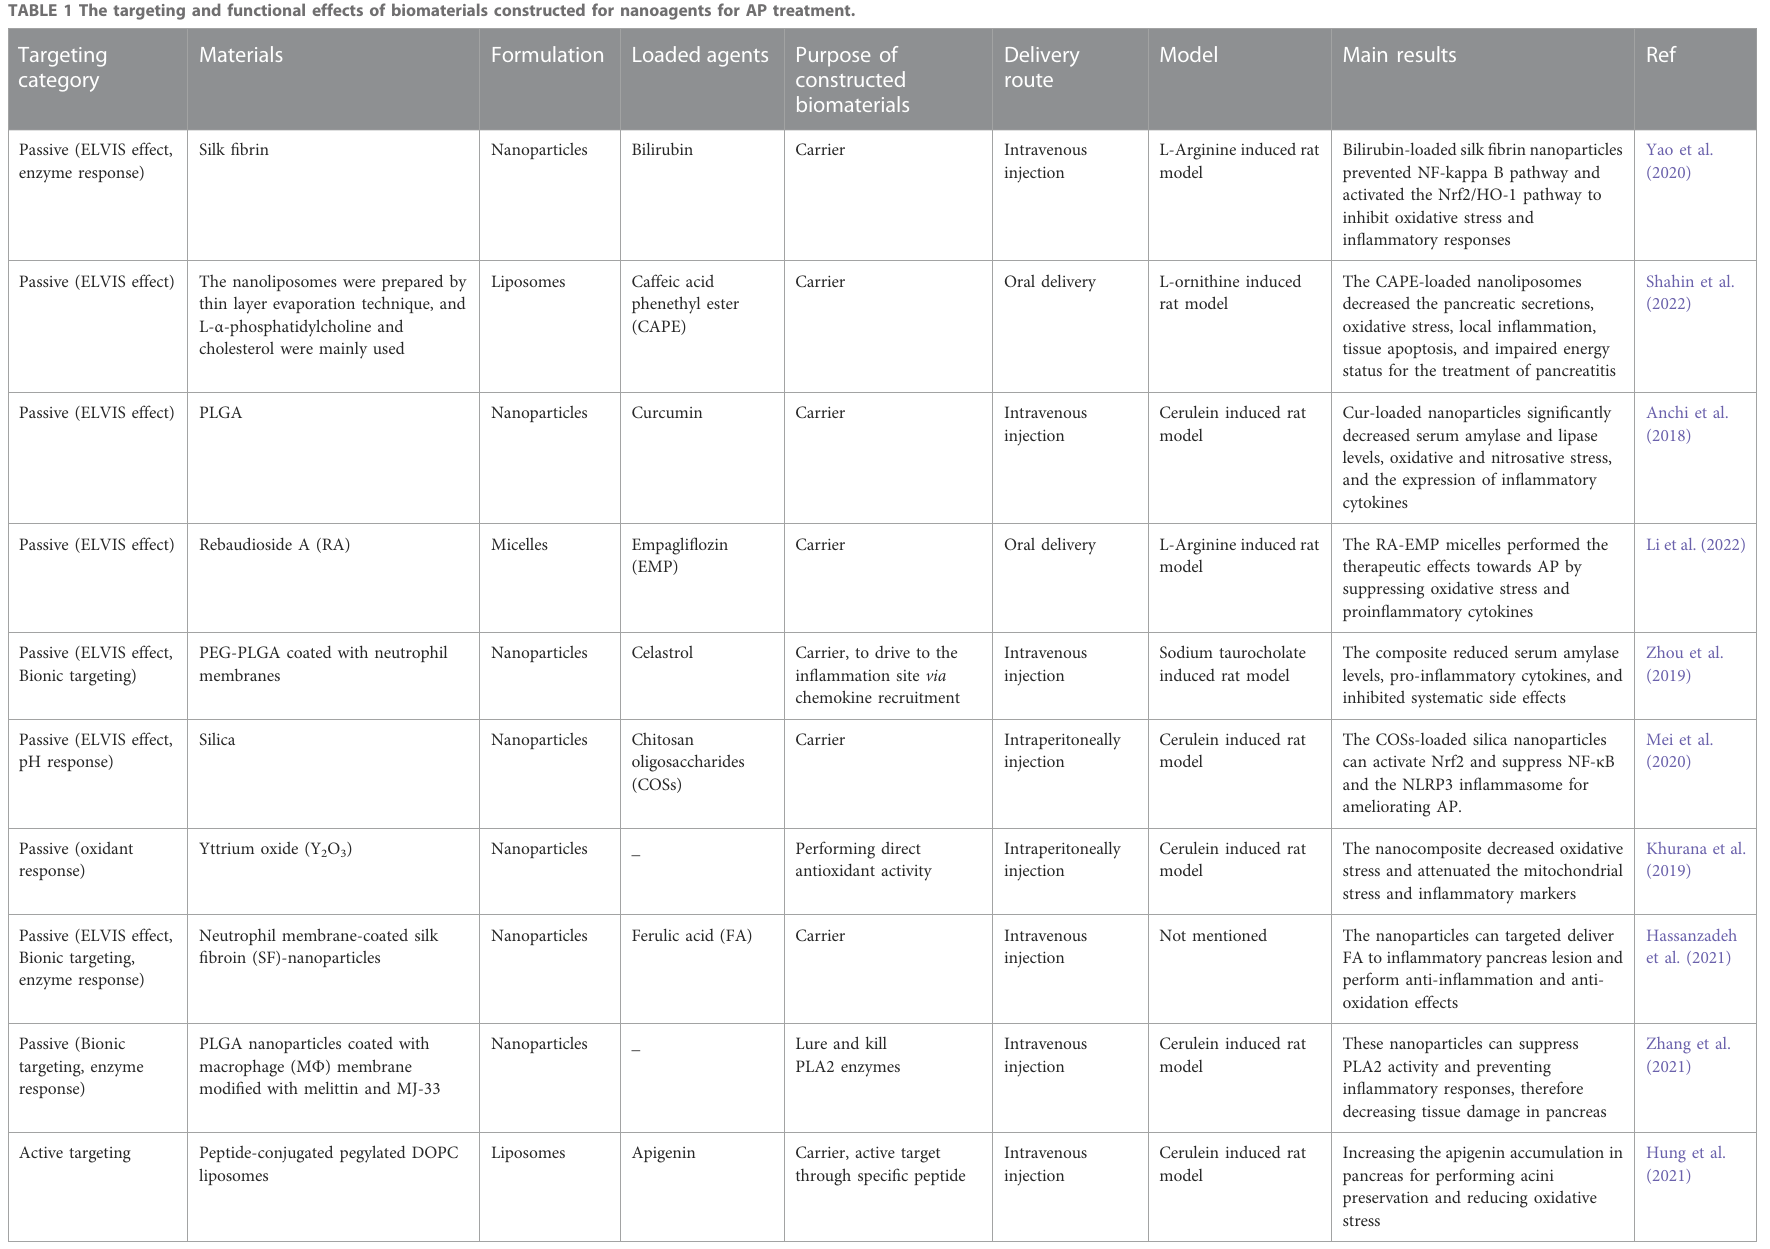
TABLE 1 The targeting and functional effects of biomaterials constructed for nanoagents for AP